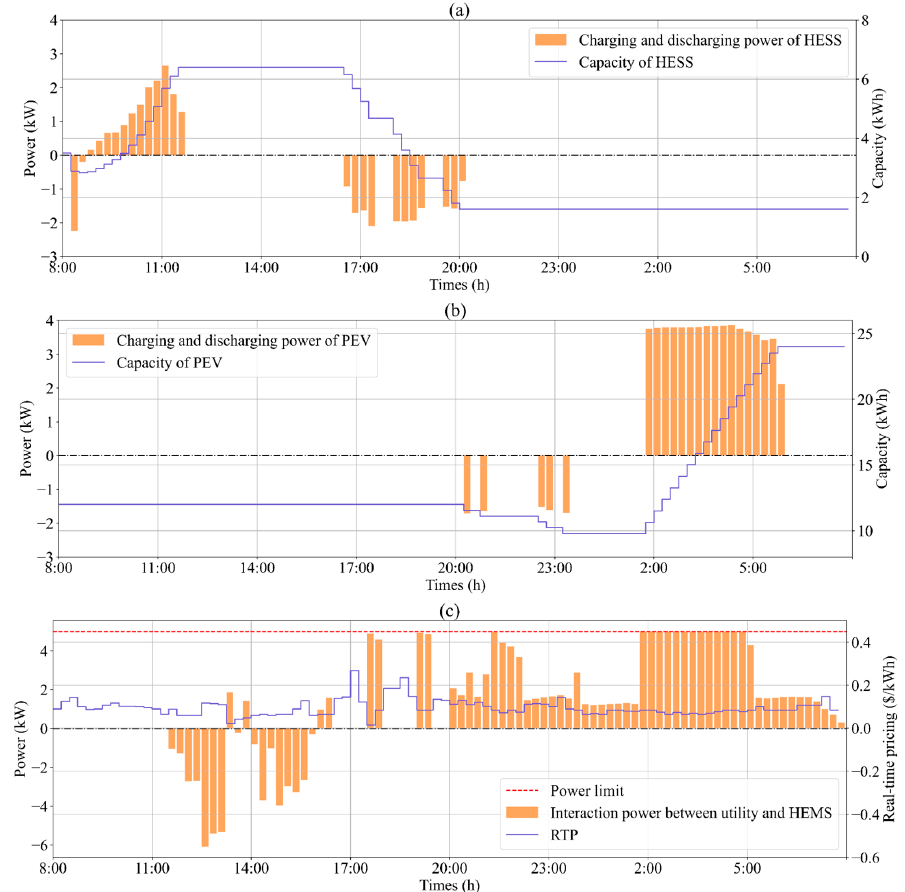
Figure 13. Load profiles for ( a ) HESS in HESS2H mode, ( b ) PEV in V2H mode, and ( c ) H ‐ MG combined mode segmentation strategy.